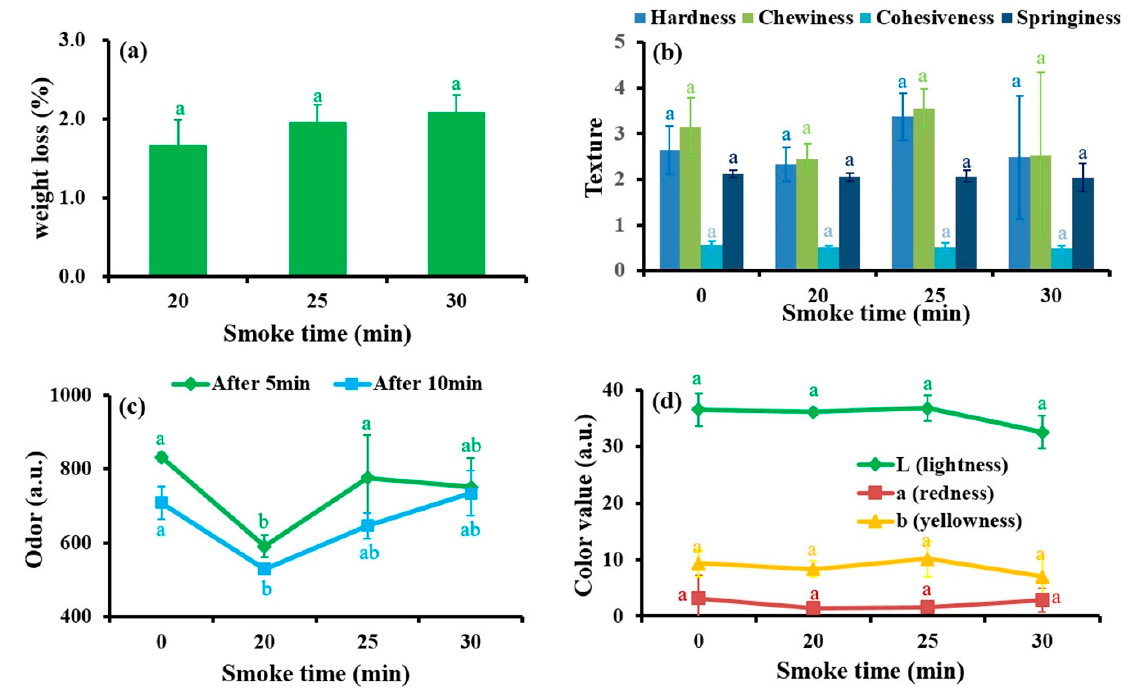
Figure 3. Changes of weight loss ( a ), texture analysis ( b ), odor ( c ), and color value ( d ) in hot smoked CM fillet products with different smoking time. The data were stated as mean ± std ( n = 10), where different letters were statistically different ( p < 0.05).